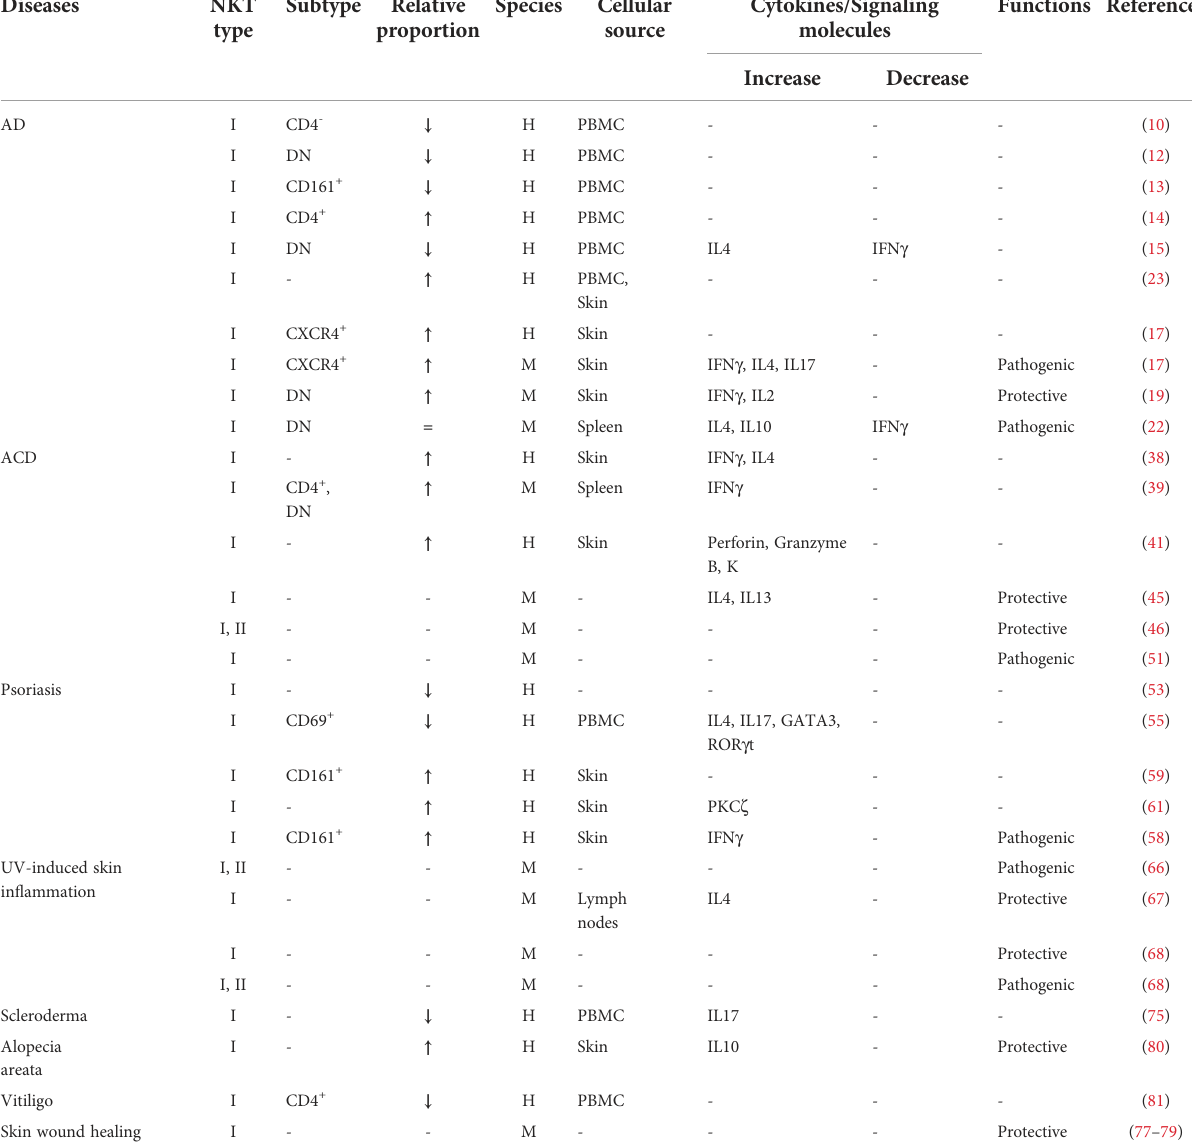
TABLE 1 Roles of CD1d-restricted NKT cells in various in fl ammatory skin diseases.